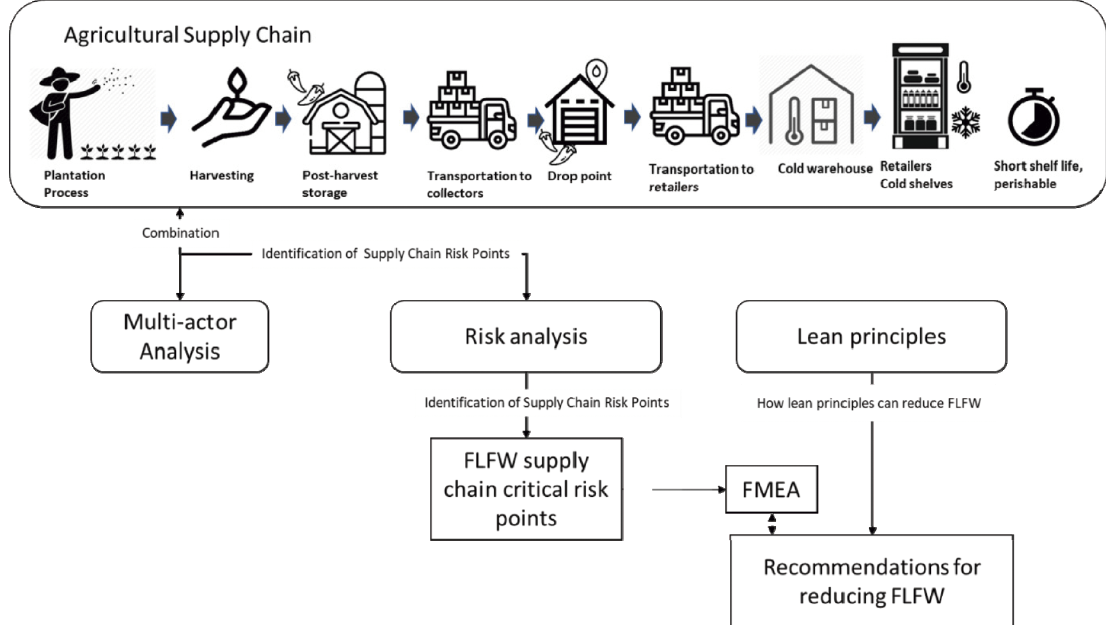
Figure 2. Concept of risk analysis for an agricultural supply chain